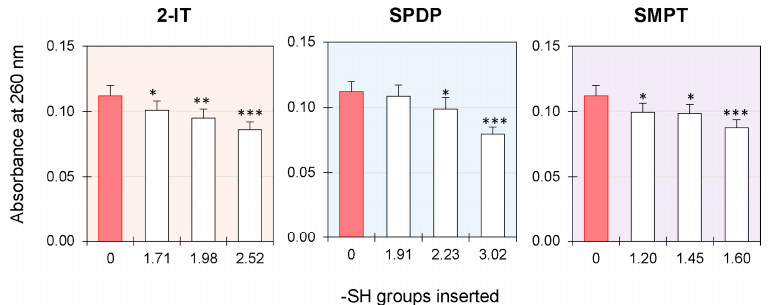
Figure 2. Polynucleotide: adenosine glycosylase (PNAG) activity assay of derivatized saporin on herring sperm DNA. PNAG activity of 3 µg of native saporin (red bars) and saporin derivatized with 2-IT, SPDP or SMPT (white bars) was assayed, as indicated in Materials and Methods, and the absorbance of adenine released was measured at 260 nm. Results are expressed as means ± SD of three different experiments, each conducted in duplicate. SD never exceeds 10%. Data were analyzed by Mann–Whitney U test (confidence range 95%; * p < 0.05, ** p < 0.01, *** p < 0.001 derivatized saporin versus native saporin).